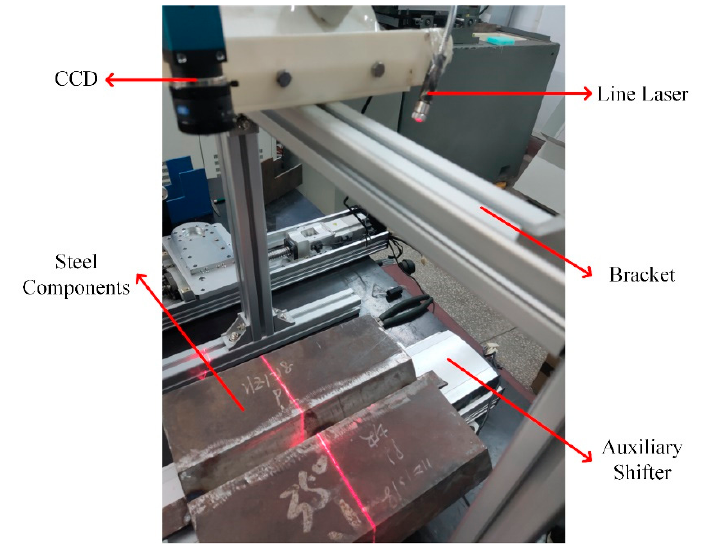
Figure 17. Structure of the detection stand.